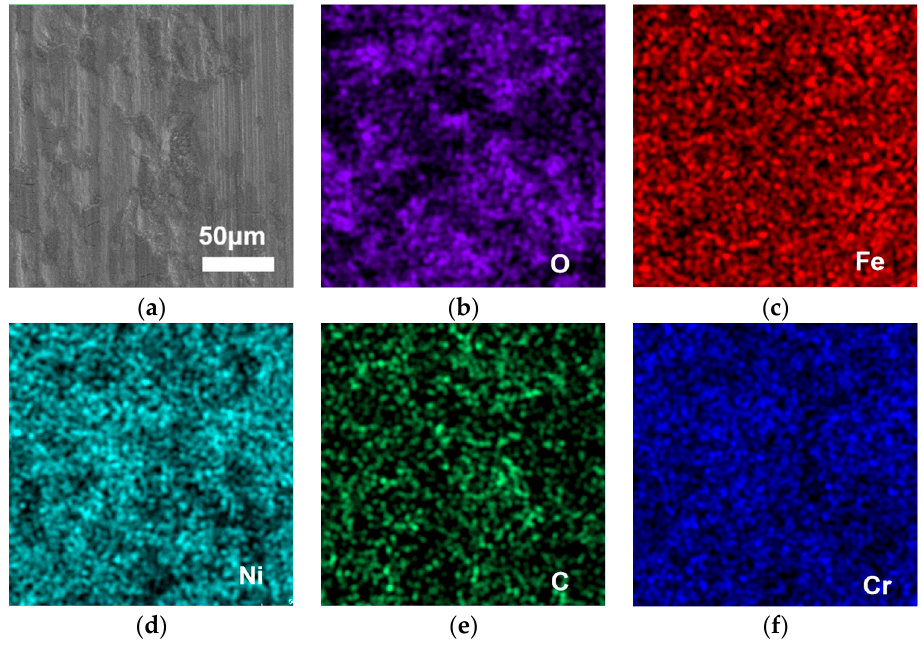
Table 7. Substrate atoms for each element content (wt%).